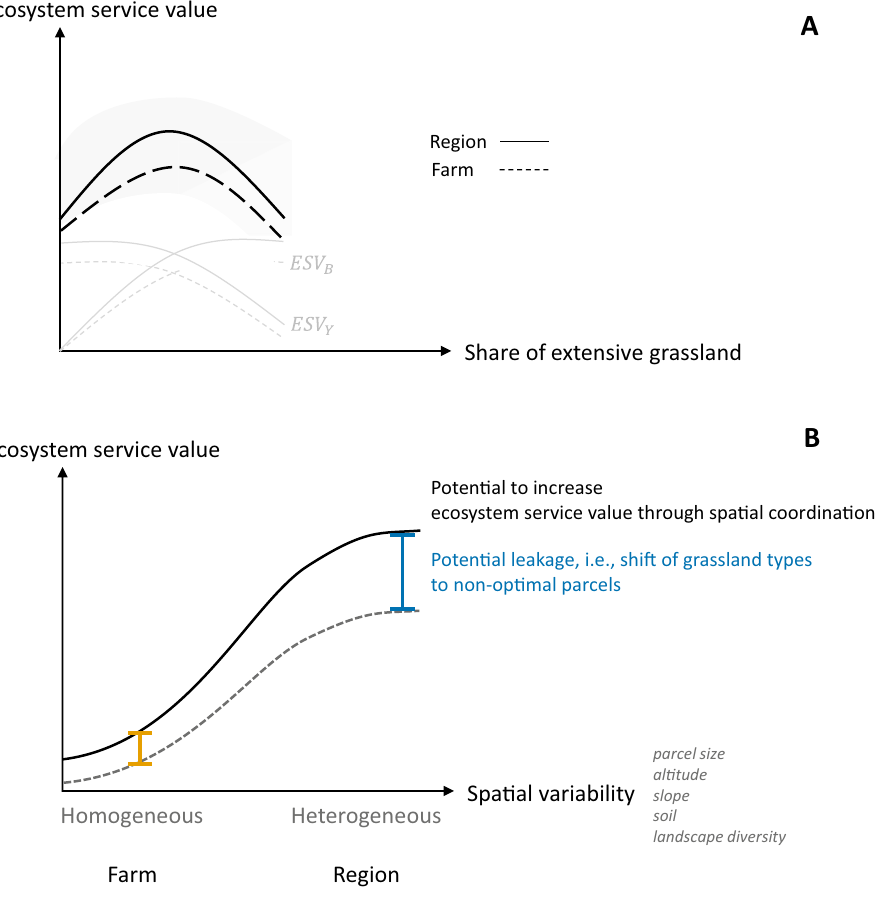
service provision 40 . The spatial variability generally increases when enlarging the spatial scale 51 , e.g., from the farm to the region, and consequently also the overall economic gains from allocating grassland types differently in space (cf. Fig. 1B). Second, policy incentives that aim to optimize the provision of ecosystem services through the allocation of grassland management in space must consider the economic nature of the underlying values. With increasing spatial variability, the potential of an inefficient allocation increases because of farmers’ private optimization of marketable ecosystem services 13,52 . Combining these two mechanisms, we hypothesize that shifting the spatial scope from the farm to the regional scale increases the expected provision of multiple, but negatively correlated indicators of ecosystem services simultaneously increase potential cost inefficiencies from policy interventions. The form of the relationship between ecosystem service values and the inefficiency of the policy incentive will emerge from the spatial variability, the correlation between multiple services as well their economic values and remains an empirical and context-specific question. We apply this concept in a Swiss case study by analyzing the potential economic gains and policy implica- tions of a spatial redistribution of grassland management regimes and intensities using a spatially explicit bio- economic simulation approach. Our simulation approach accounts for variability across space and management and considers price and willingness to pay variability in the economic values of three ecosystem services. We here distinguish between marketable ecosystem services (forage yield in dt/ha and carbon sequestration in t/ha and year) and non-marketable values of habitat maintenance (number of vascular plant species per ha and year).